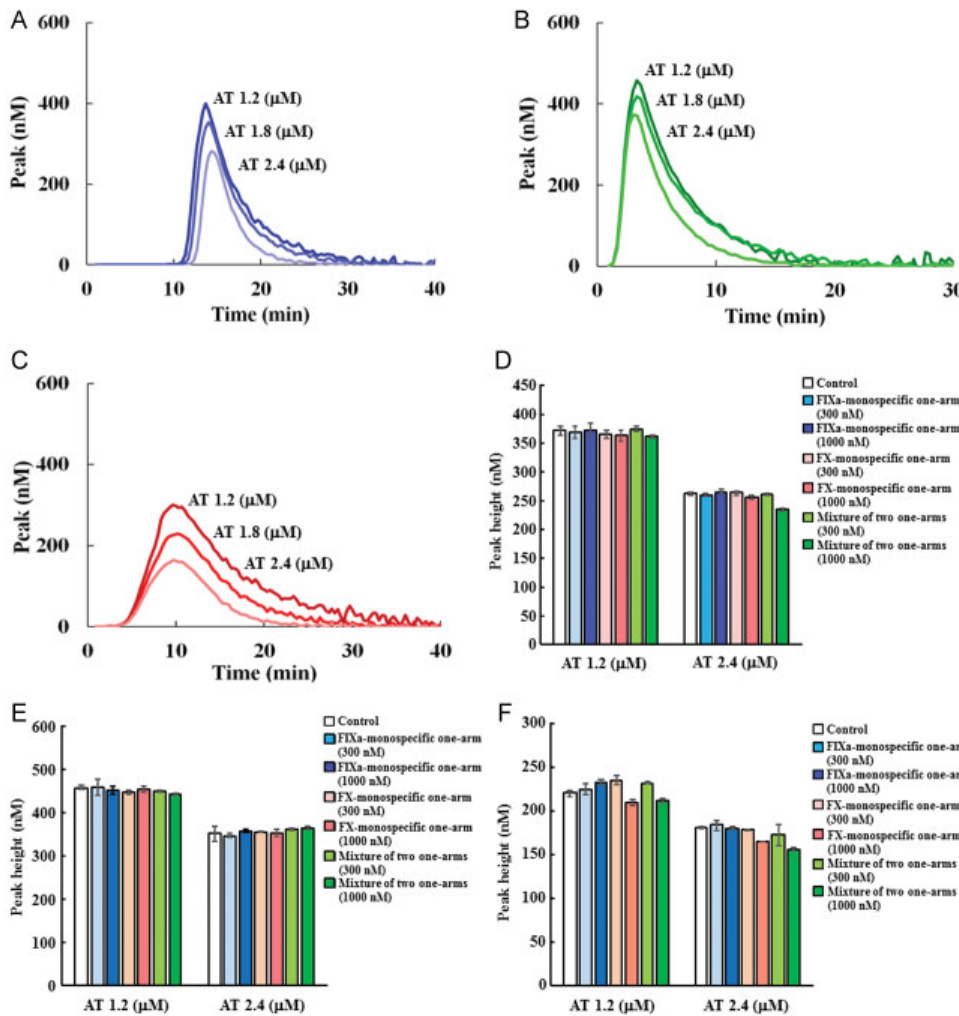
Fig. 3 Effects of AT and FIXa and FX monospeci fi c one-armed antibodies on thrombin generation in AT-depleted plasma. Effects of various concentrations of ATon the thrombin generation parameter peak height in AT-depleted plasma triggered by ( A ) FXIa, ( B ) high concentration of TF, and ( C ) low concentration of TF. Data were collected in triplicate and representative thrombograms are shown. Effects of various concentrations of anti-FIXa and anti-FX monospeci fi c one-armed antibodies, and mixtures of the two one-armed antibodies on the thrombin generation parameter peak height in AT-depleted plasma triggered by ( D ) FXIa, ( E ) high concentration of TF, and ( F ) low concentration of TF in the presence of 1.2 or 2.4 μ M of AT. Data are expressed as mean (cid:2) SD ( n ¼ 3).